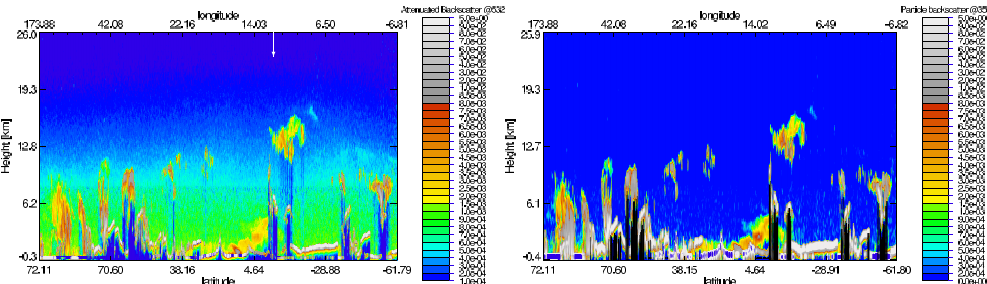
Fig. 4. Left, CALIPSO 532nm total attenuated backscatter (km − 1 sr − 1 ) measured on 1 January 2007 at 00:22–00:49UTC. The white arrow at − 4.32 degrees latitude, 12.12 degrees longitude points to the location of the raw data displayed in Fig. 1. Right, retrieved particle backscatter (km − 1 sr − 1 ) from the inversion algorithm and converted to 355nm wavelength. Black spots indicate regions where no particles could be retrieved by the